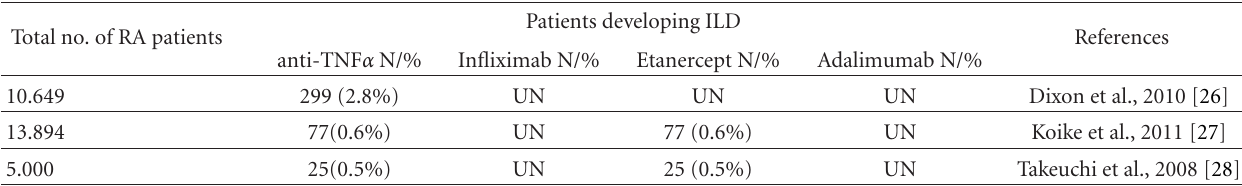
Table 2: Number and percentage of RA patients presenting ILD under anti-TNF α